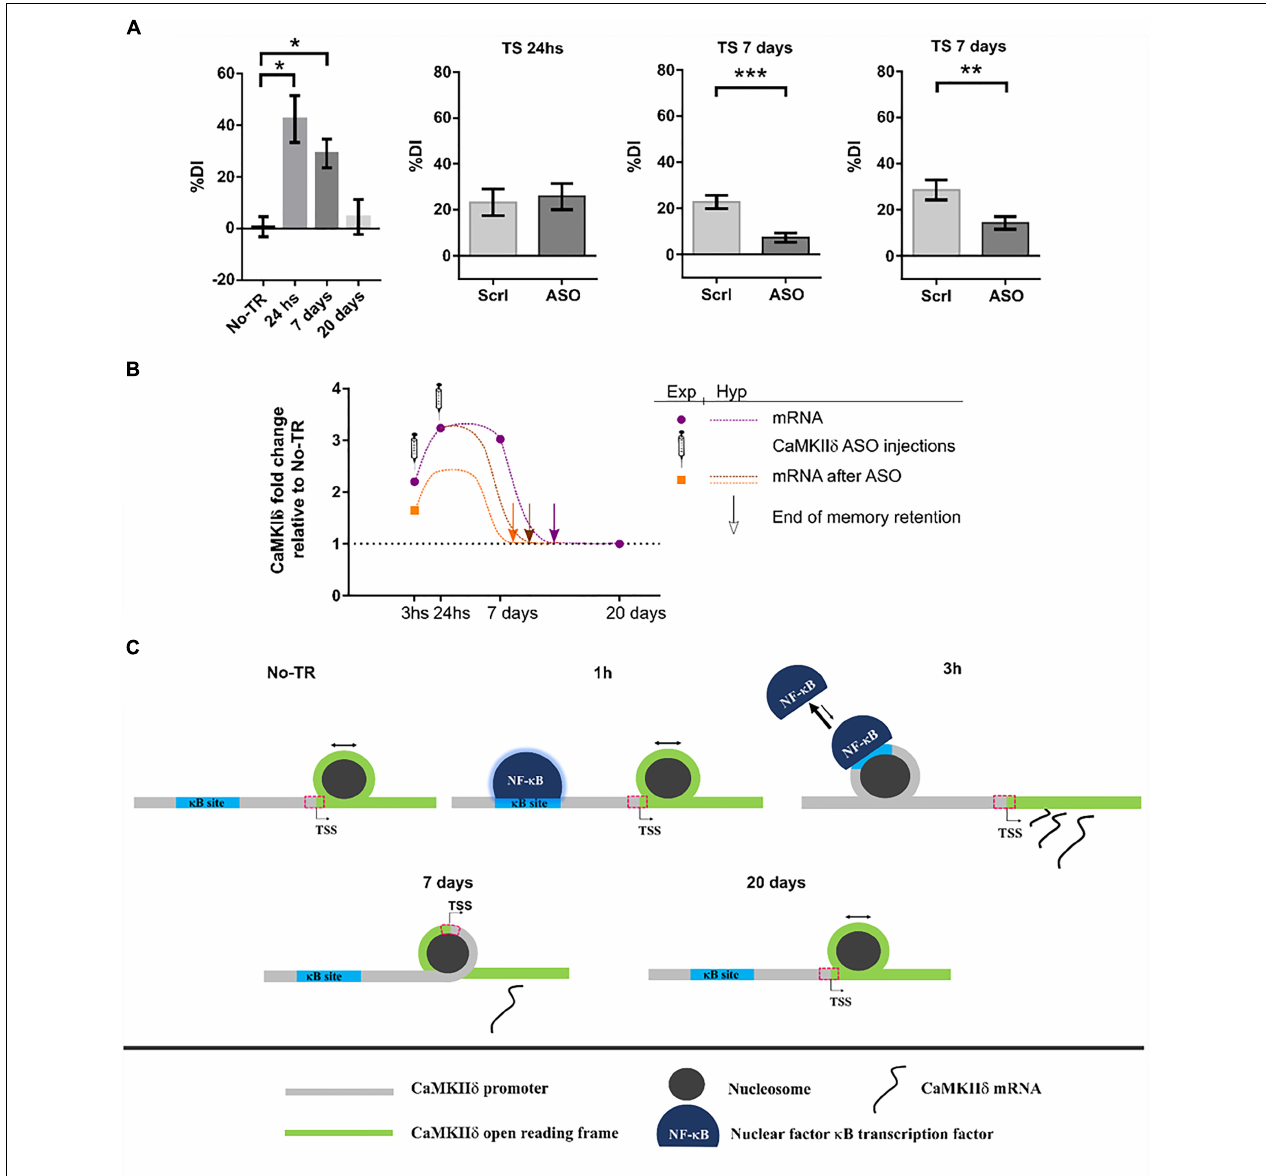
FIGURE 4 | CaMKII δ role in memory persistence. (A) Left graph shows mice performance 24 h, 7 days, and 20 days after training to Novel Object Recognition task compared to non-trained animals (No-TR). Performance is expressed as a discrimination index (%DI) that is an indicator of the time spent exploring a novel object over a familiar one (Zalcman et al., 2018). Note that memory retention decays with time and is significantly above the control group when animals are tested 24 h and 7 days after training. Infusion of an oligonucleotide antisense to CaMKII δ mRNA (ASO), which effectively decreases CaMKII δ expression, 2 h after training leads to memory impairment when animals were tested 7 days after but not 24 h (middle graphs). Seven days memory impairment was also found when CaMKII δ ASO was injected 24 h after training (right graph). Scrl: scrambled oligonucleotide used as a control (with permission of Springer Nature). (B) Graph showing the mRNA levels for CaMKII δ measured experimentally at different time points after training and after ASO administration (purple circles and orange square, respectively) together with a hypothetical curve (dash lines). Based on our results, we propose that memory can be recalled as long as CaMKII δ mRNA levels are above basal condition. Arrows indicate a hypothetical time point at which CaMKII δ mRNA return to basal levels and thus memory retention is lost. ASO administration shifts mRNA curve in such a way that only 7 days memory is affected. (C) Nucleosome occupancy on κ B and transcription start sites (TSS) is affected by training to a NOR task. One hour after training NF- κ B is bound to its κ B site in CaMKII δ promoter but there is no change in nucleosome occupancy at this site compared to non-trained animals (Federman et al., 2013; Zalcman et al., 2018). Three hours after training nucleosome occupancy is increased in κ B site, and it is decreased on TSS site, there is also an increase in CaMKII δ transcription. Since nucleosome occupancy at specific regions has been proposed to disfavor protein binding (Bai and Morozov, 2010), the observation at 3 h suggests that NF- κ B binding decreases while CaMKII δ transcription is enhanced. Seven days after training nucleosome occupancy at TSS is increased presumably decreasing the rate of gene expression. Finally, 20 days after, when memory retention is lost, nucleosome occupancy on TSS site becomes return to the level of non-trained animals. ∗ p < 0.05; ∗∗ p < 0.005; ∗∗∗ p < 0.0005.